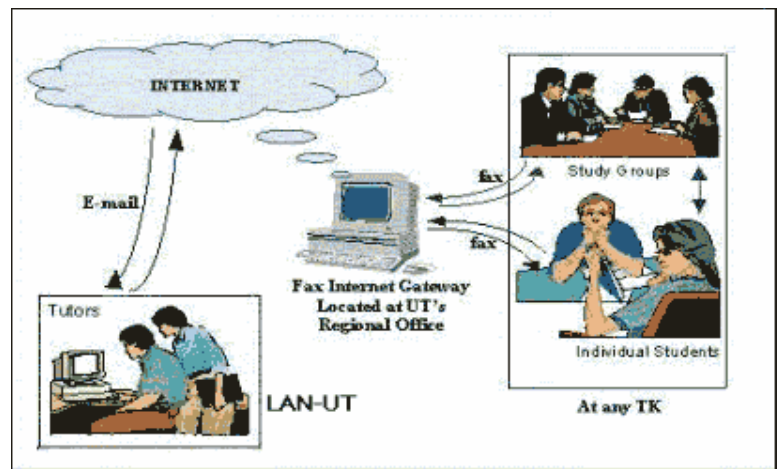
Figure 2. Communication within tutorials using Fax-Internet